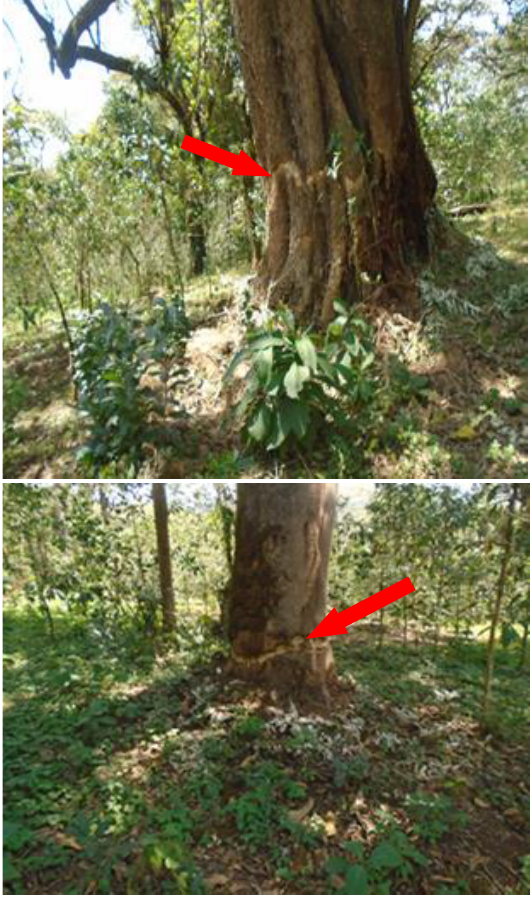
Bee flora debarking observed in SFC